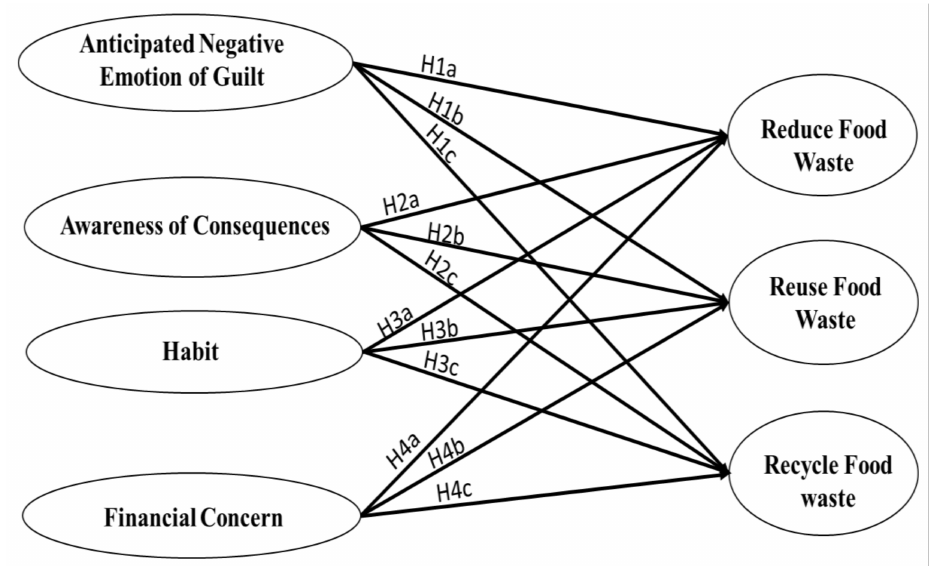
Figure 1. Conceptual